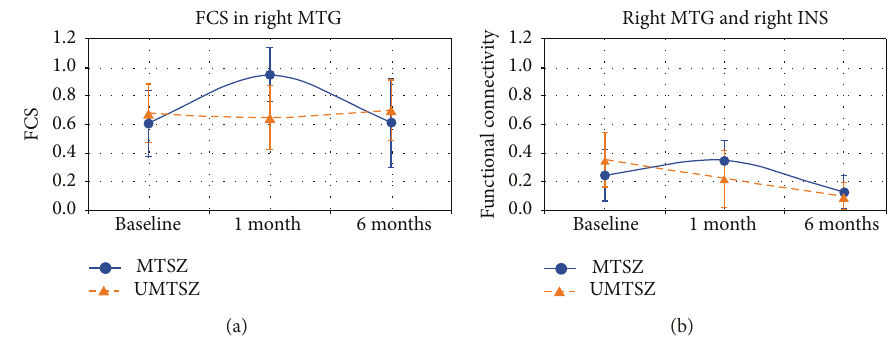
Figure 3: 6-month e ff ects of music intervention versus nonmusic intervention on brain functional connectivity strength (FCS) and functional connectivity (FC) in patients with schizophrenia. The data were expressed as the mean value ± standard error. (a) denotes the long-term e ff ects of music intervention versus nonmusic intervention on FCS of the middle temporal gyrus (MTG) in patients with schizophrenia. (b) denotes the long-term e ff ects of music intervention on FC between the MTG and right insula (INS).